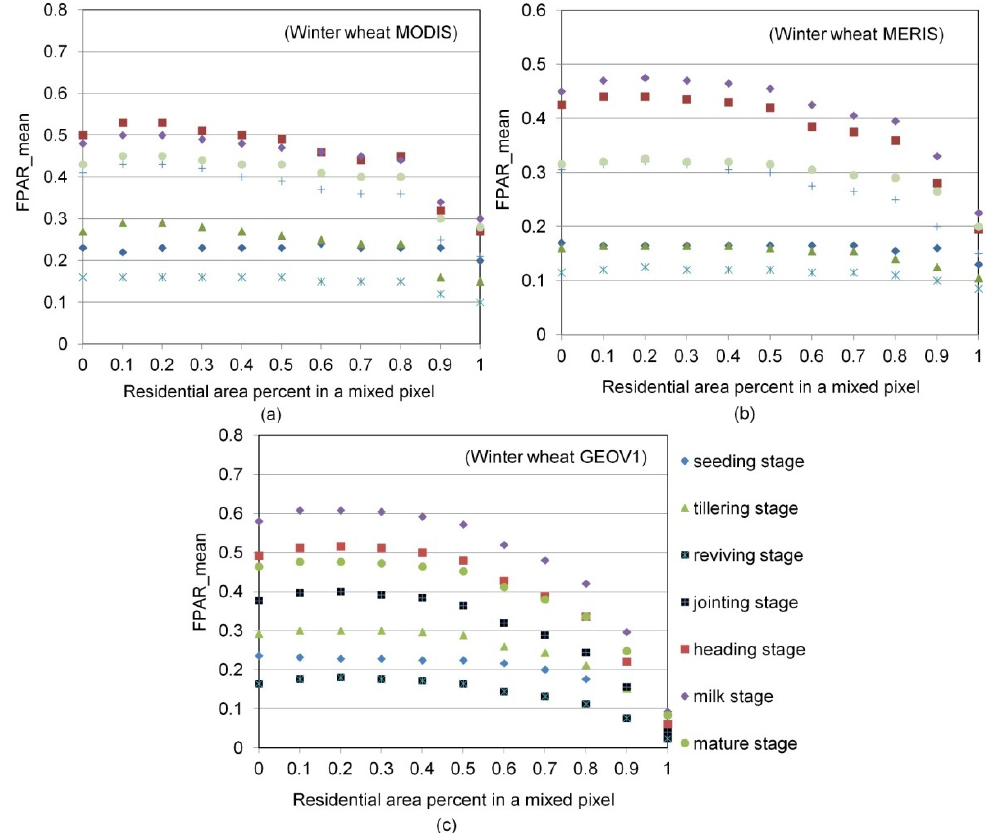
Figure 7. The changes of winter wheat ( a ) MODIS; ( b ) MERIS; ( c ) GEOV1 FPAR in mixed pixel with residential area at different growth stages.